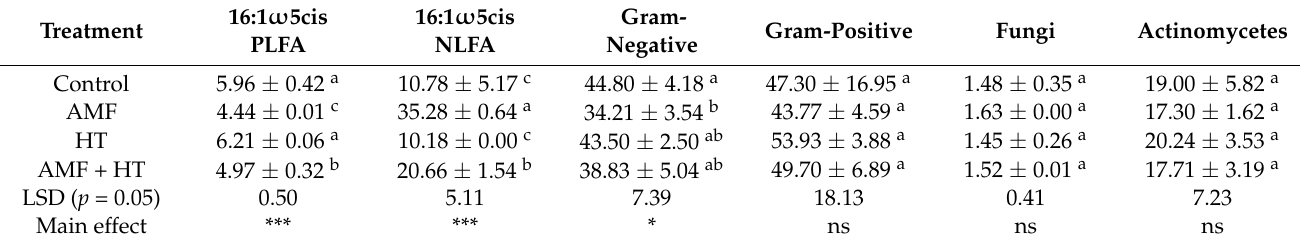
results are expressed as mean values and standard deviation